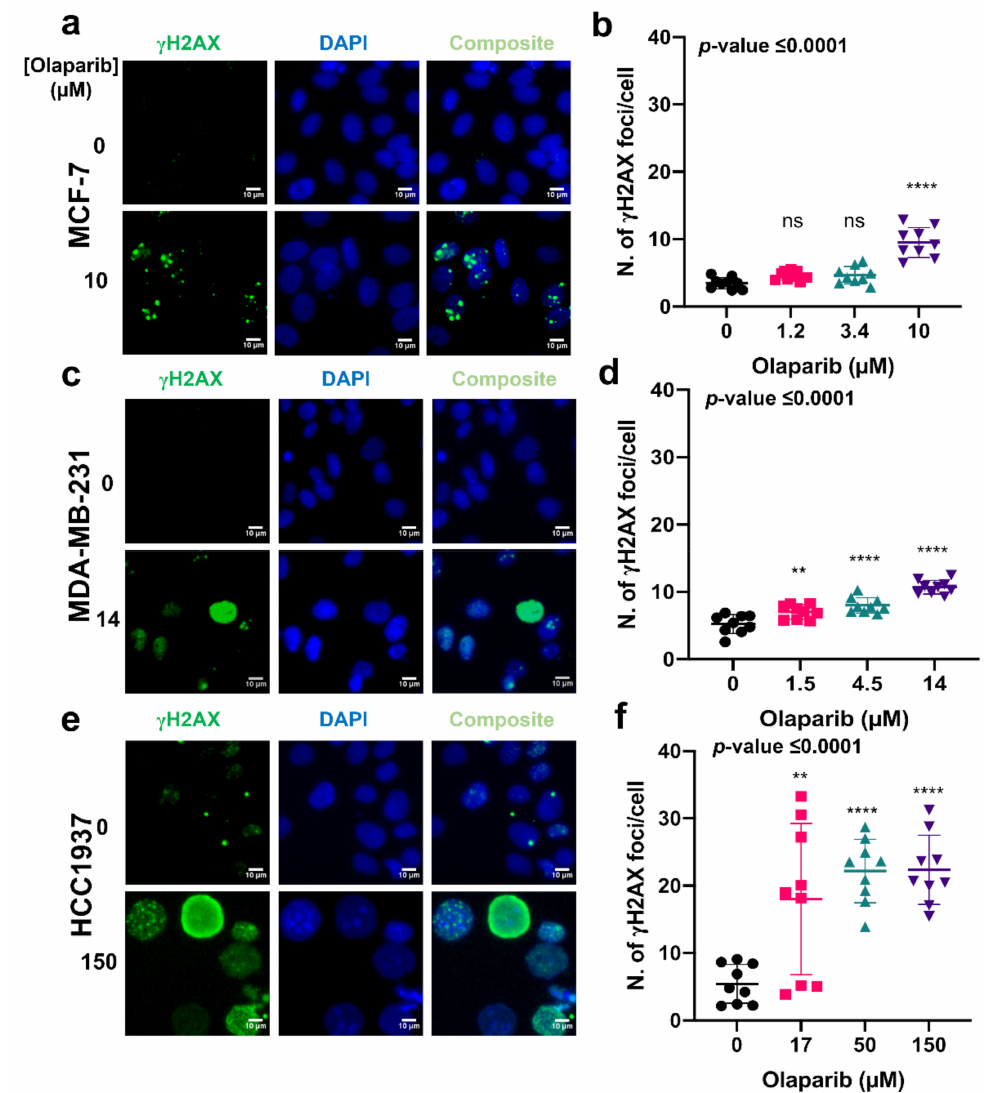
Figure 3. The formation of γ H2AX foci formation in response to treatment with either growth medium or medium containing olaparib at the IC 50 dose. Representative images of immunolabelled γ H2AX foci (green), DAPI (blue) nuclear counterstain and composite ( γ H2AX and DAPI) in MCF- 7, MDA-MB-231, and HCC1937 cells treated with for seven days ( a , c , e ). Corresponding γ H2AX foci counts determined using Cell Profiler ( b , d , f ). (>100 cells per sample). Dunnett’s multiple comparison test was used as a follow up to ANOVA and corresponding p -values were represented as: ns, non-significant; **, 0.005; ****,